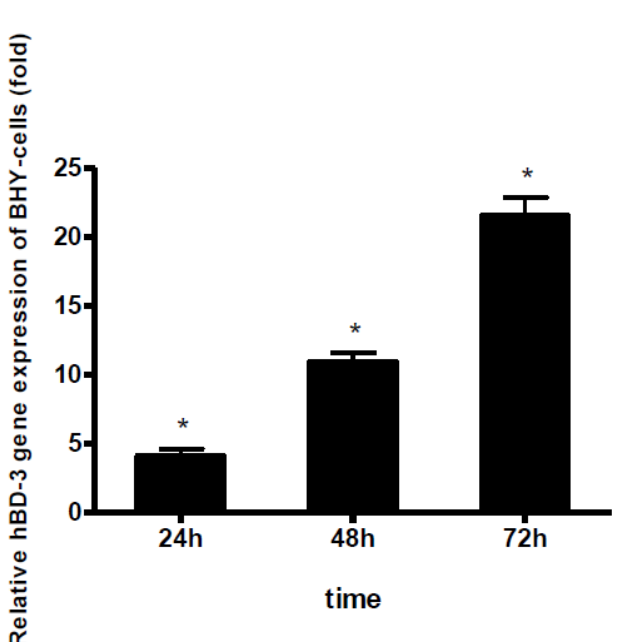
Figure 6. Relative hBD-3 gene expression of BHY cells after hBD-1 stimulation (50 nM). Statistically significant differences compared to the unstimulated control are shown with asterisks(* = p < 0.05). Mean values of n = 6 experiments + SD are